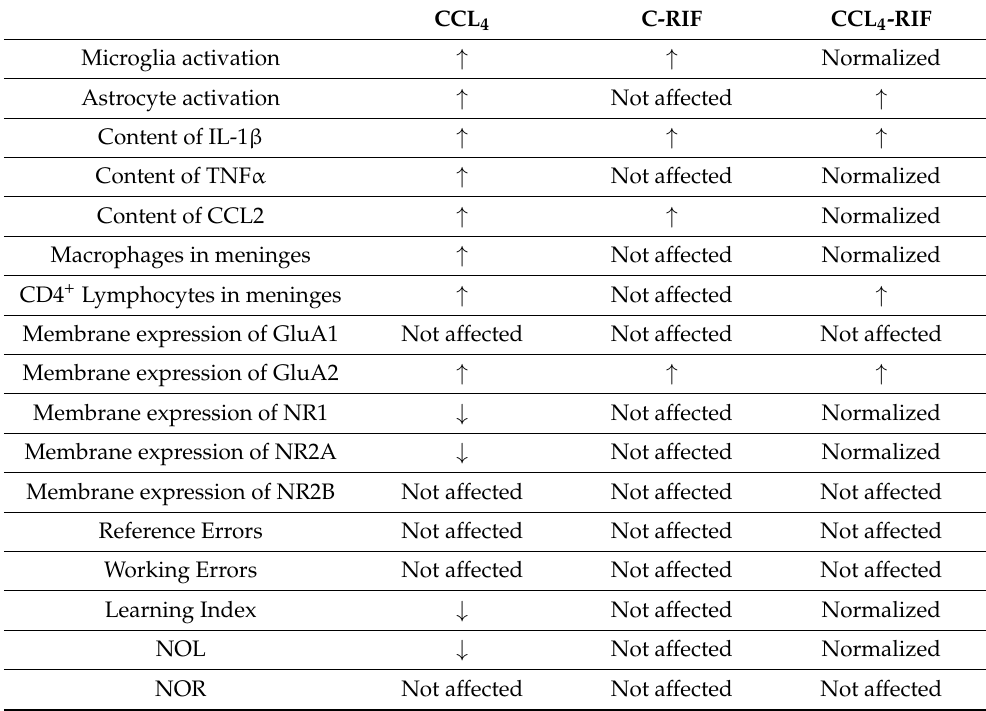
Table 1. Summary of CCl 4 and rifaximin